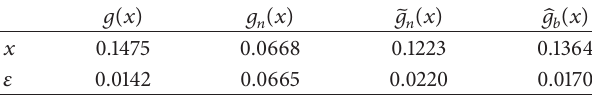
Table 1: Proximity error 𝜀 with different estimates.